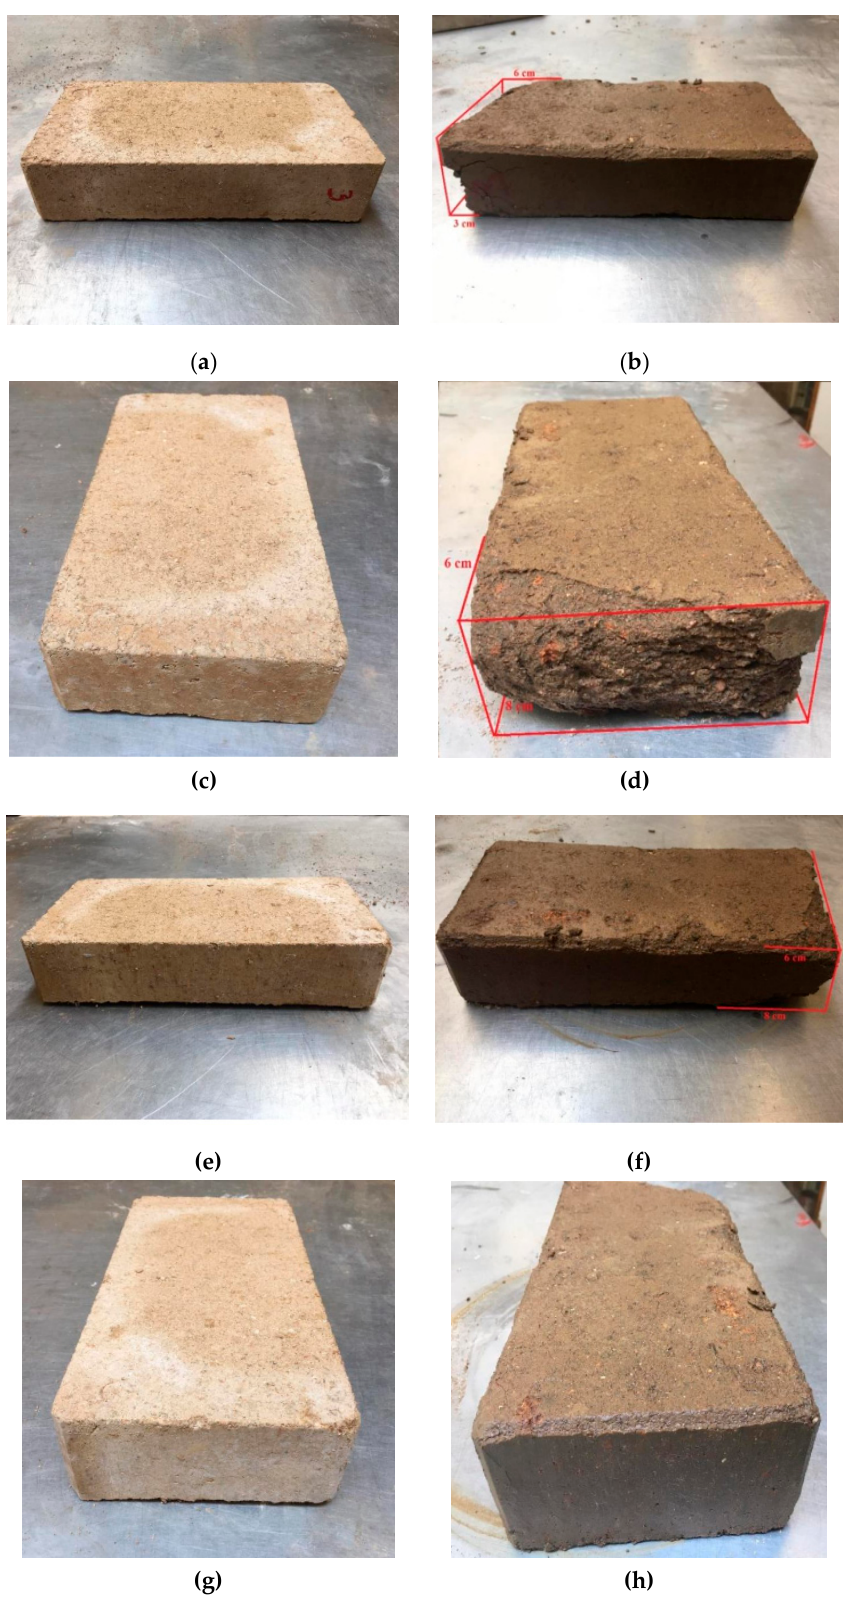
Figure 15. Accelerated erosion test. ( a ), ( c ), ( e ), and ( g )—four sides of the exposed face of sample 3 before the test; ( b ), ( d ), ( f ), and ( h )—four sides of exposure face of sample 3 after two hours testing.